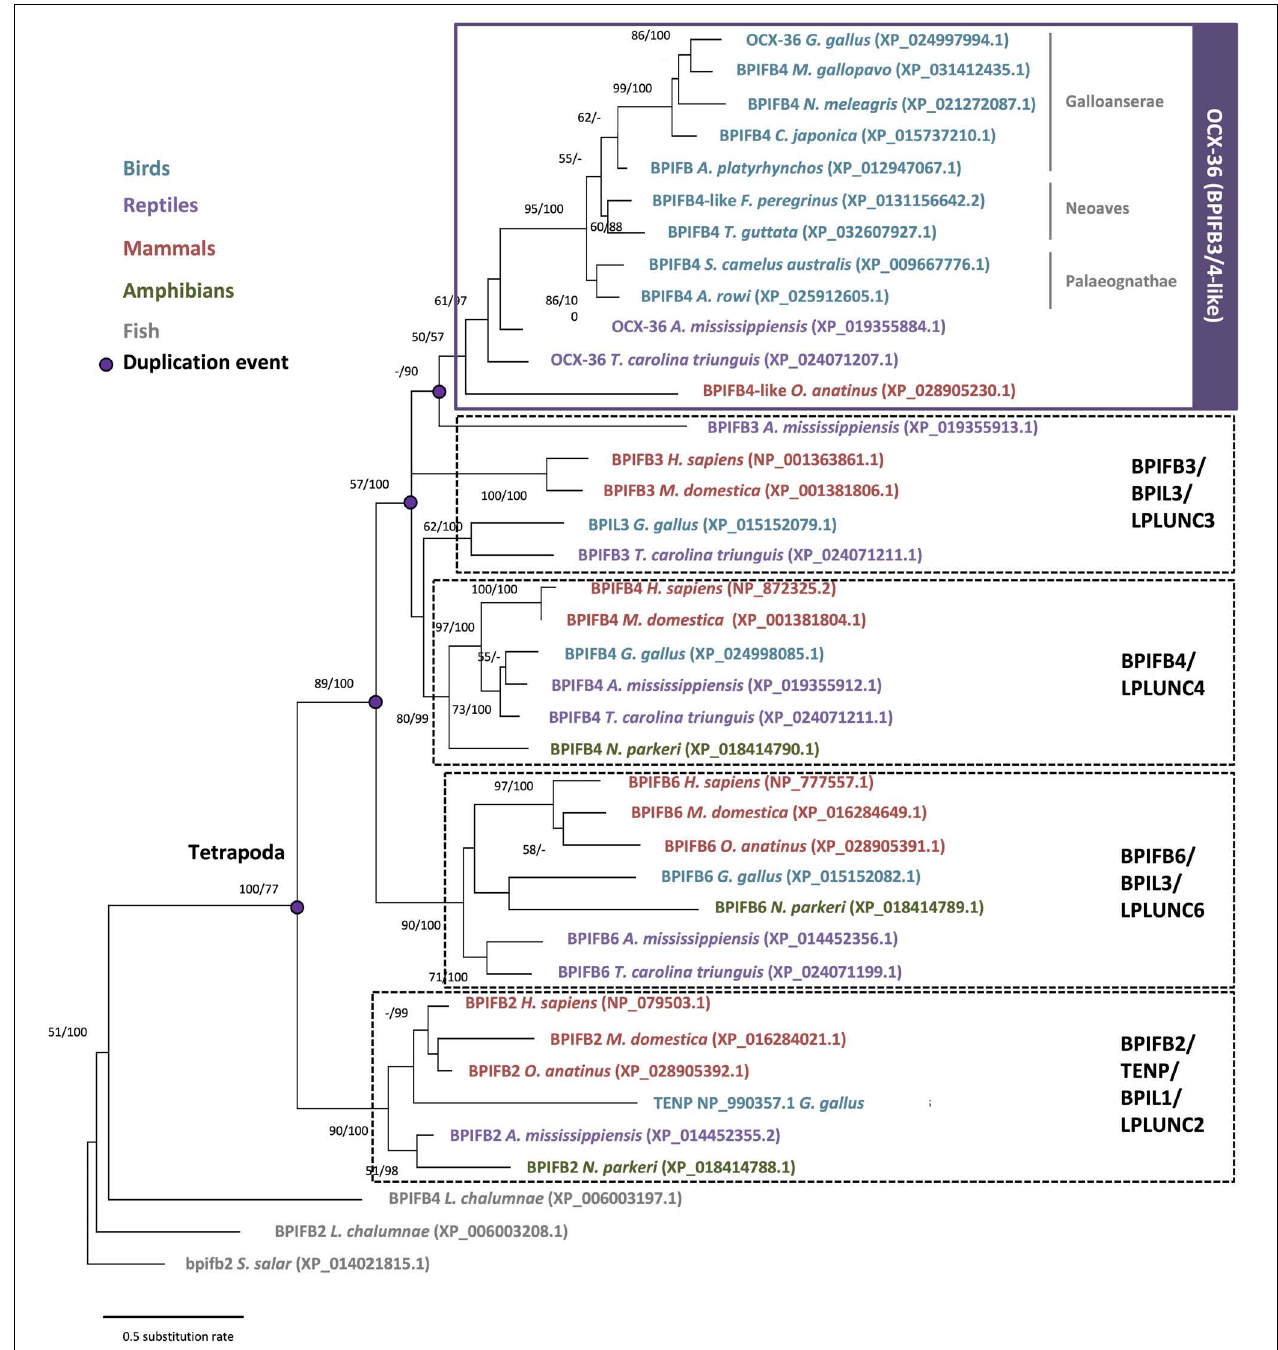
FIGURE 6 | Phylogenetic reconstruction of OCX-36 and its orthologs and paralogs in vertebrates. For phylogeny multiple alignment was performed using ClustalW and Gblocks (www.phylogeny.fr). Model of protein evolution used is JTT + G (MEGAX v10.1.8; https://www.megasoftware.net/). Topology of the tree corresponds to maximum likelihood method with 100 repetitions (MEGAX v10.1.8). Bootstrap values from maximum likelihood/Bayesian inference are indicated at each node when value is >